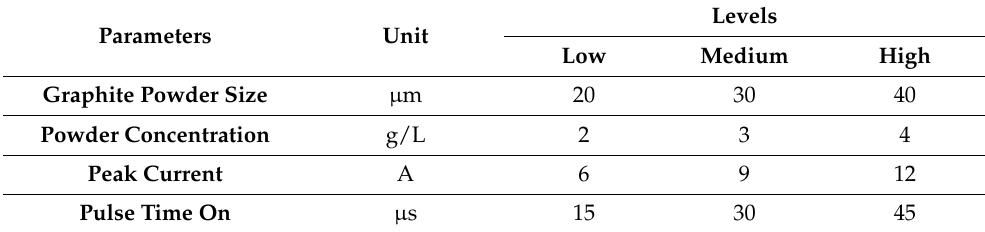
Table 3. Parameters and Levels used in the current